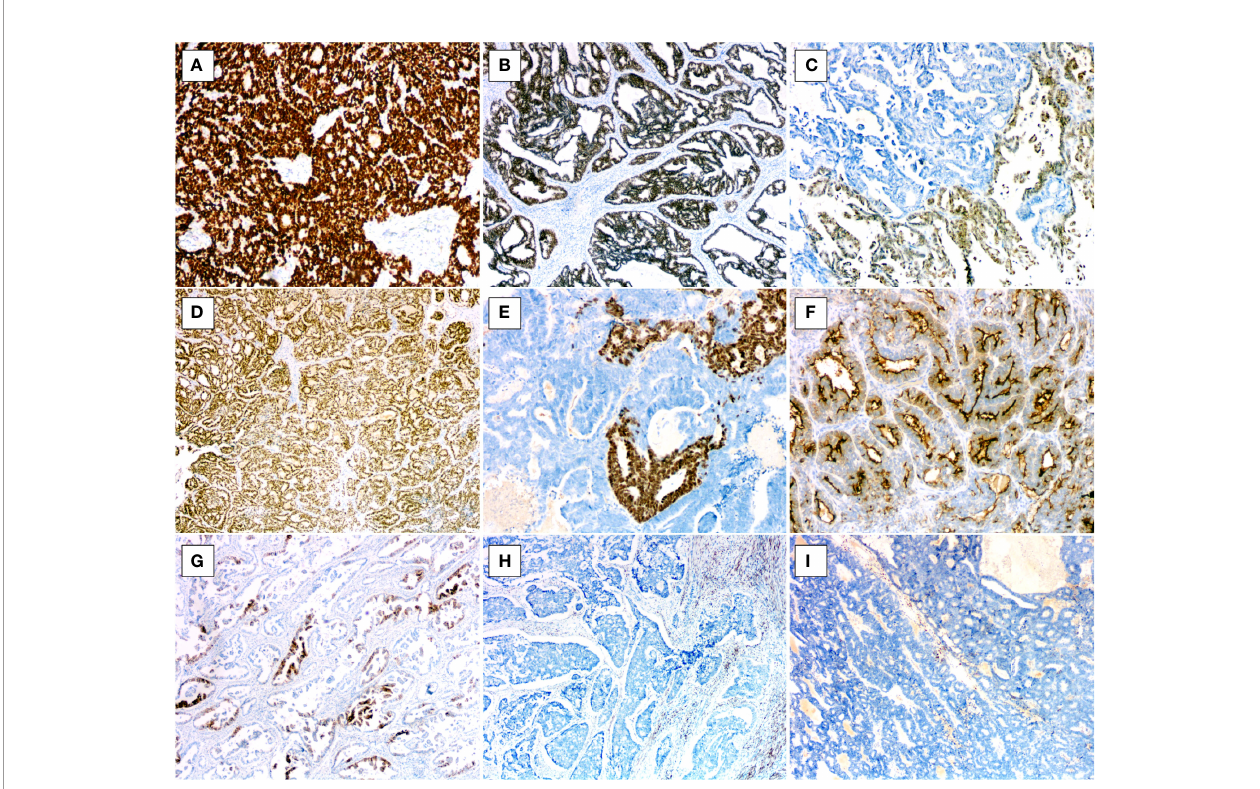
FIGURE 5 | Immunohistochemical features of uterine corpus MLA. (A) Diffuse PAX8 positivity (case 3, ×100). (B) Diffuse GATA3 positivity (case 4, ×40). (C) Focal GATA3 positivity (case 1, ×100). (D) Diffuse TTF1 positivity (case 3, ×40). (E) Focal TTF1 positivity (case 4, ×100). (F) Luminal CD10 positivity (case 3, ×100).